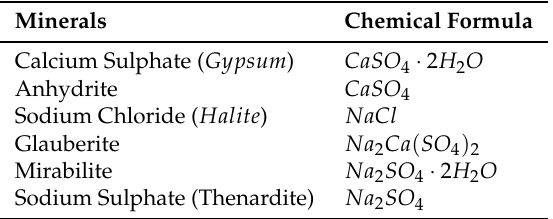
Table 2. List of minerals prior to precipitate after evaporation of Segdoud